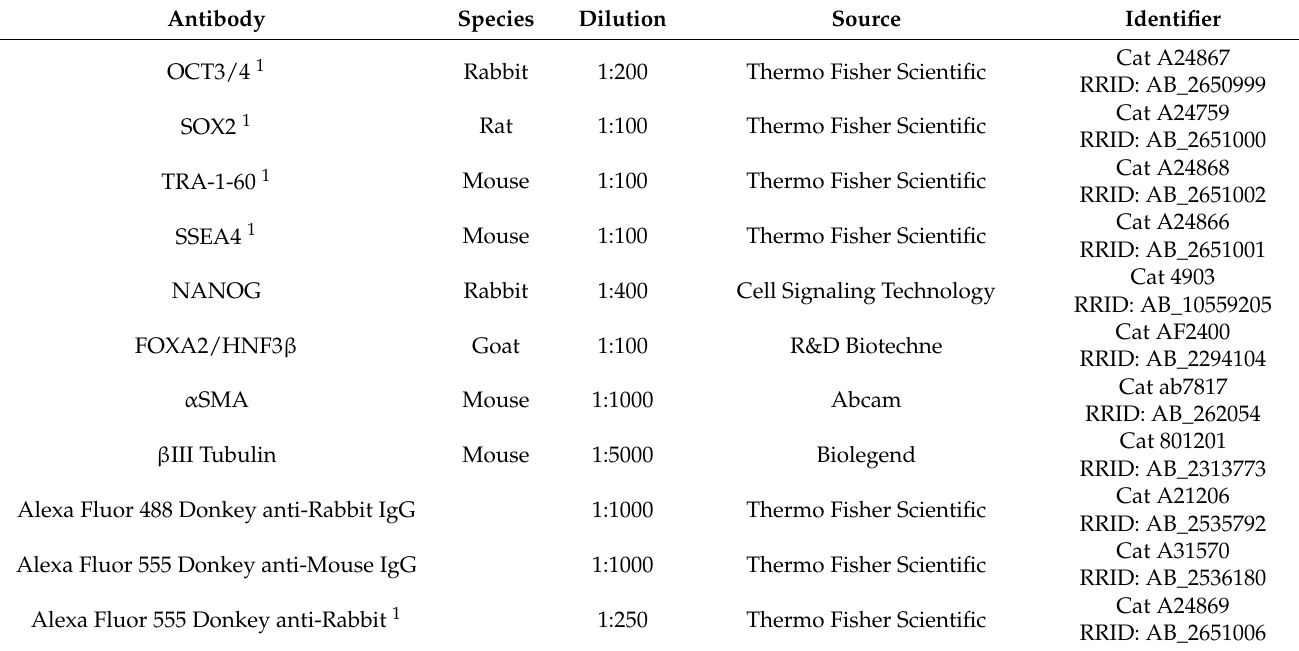
Table 1. Antibodies used for